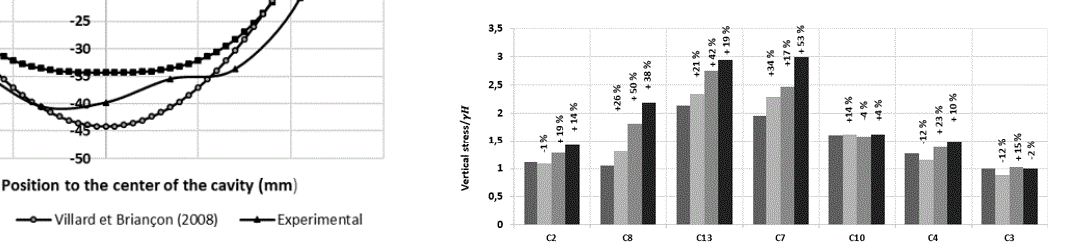
Figure 6. Comparison of experimental and analytical RG vertical displacements after cavity opening – granular soil.